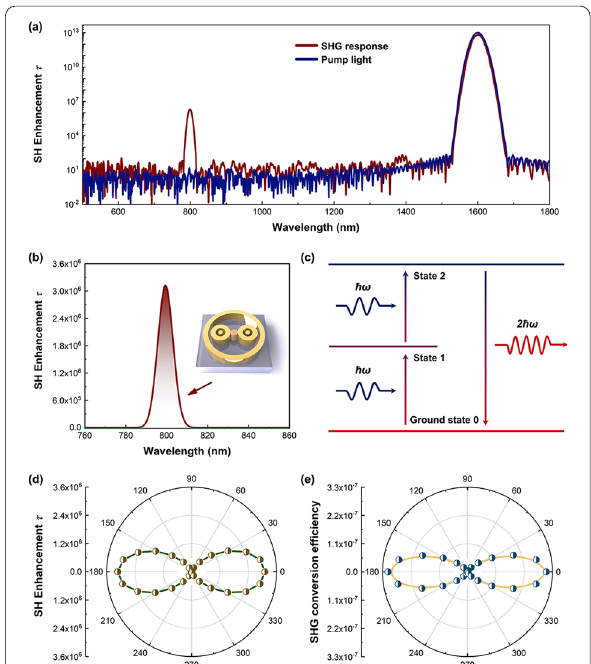
Fig. 4 Study of SH enhancement. a Log-plot spectra of SHG signal (red line) as defined by the SHG enhancement factor τ . The blue-dashed line represents the pump light with the same processing. b Characteristic SHG peak of metasurface coupled MoS 2 centered at 800 nm. The inset shows a unit of the hybrid metasurface and MoS 2 . c Scheme of the fundamental dipole transitions involved in the multi-resonant plasmon-induced SHG process. d Polar diagram of the polarization of the generated SHG signal from the hybrid metasurface. e Polar diagram of the polarization of the generated SHG signal conversion efficiency from the hybrid